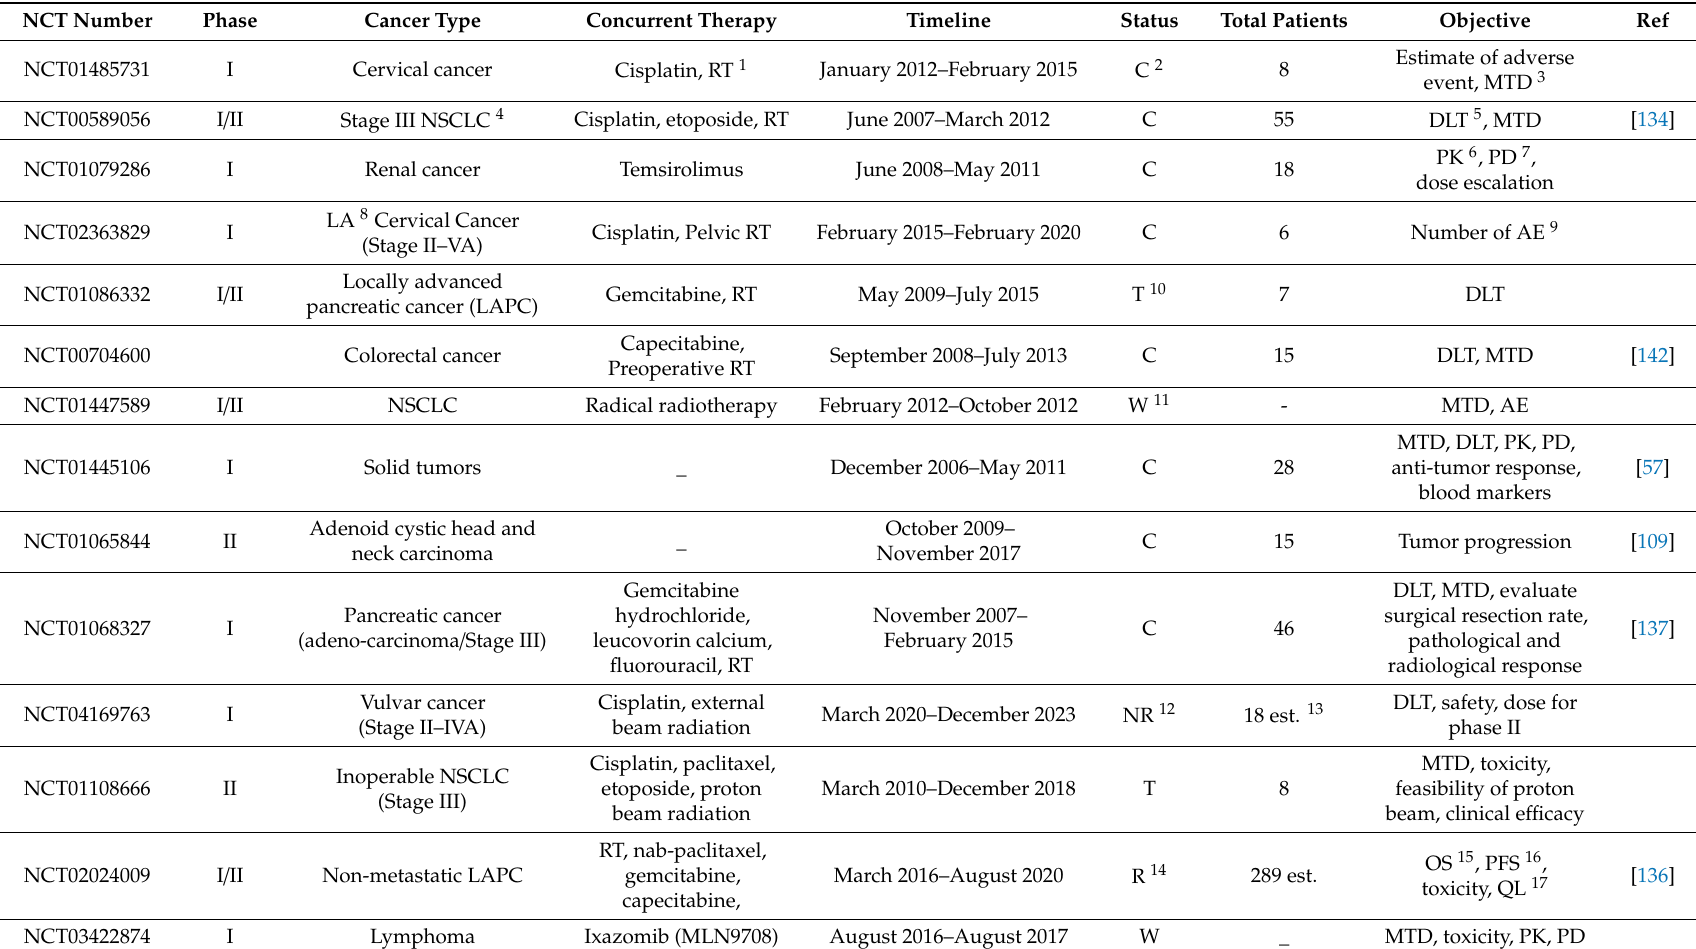
Table 2. Updated clinical trial list including nelfinavir